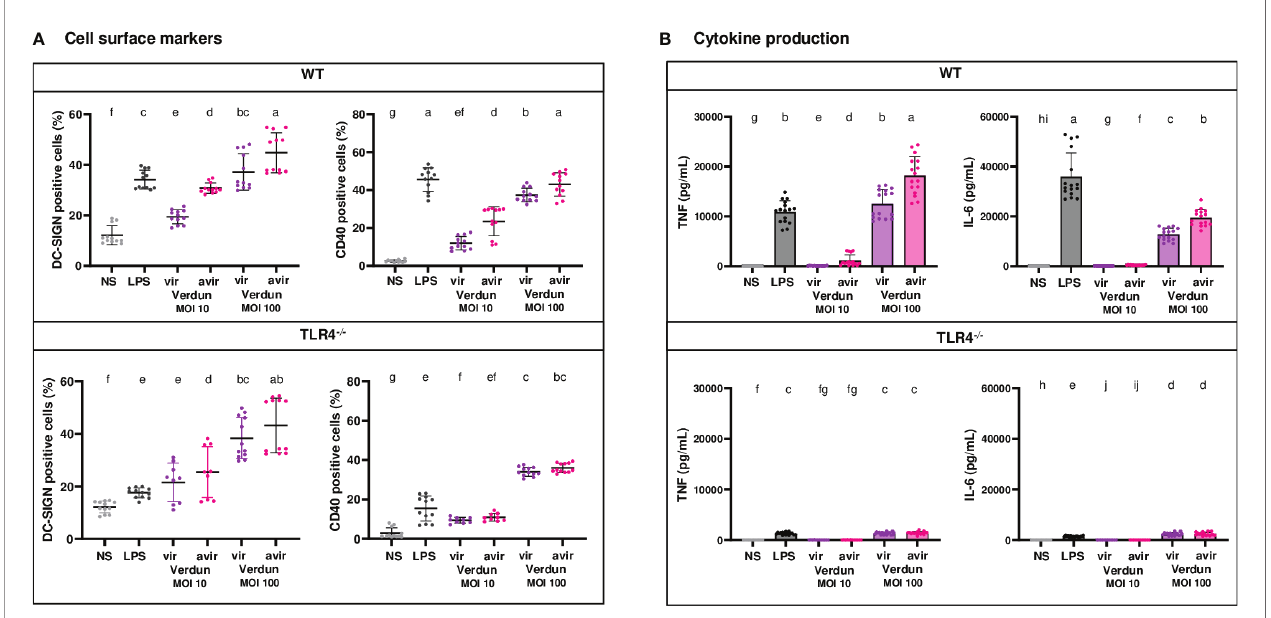
FIGURE 5 | Contribution of TLR4 in the difference of BM-DCs activation upon stimulation with virulent compared to avirulent Verdun strains of leptospires. Day 8 WT and TLR4 -/- BM-DCs from C57BL/6 mice were stimulated with virulent and avirulent leptospires from the Icterohaemorrhagiae Verdun (Verdun vir and Verdun avir) strains at a Multiplicity of Infection (MOI) of 10 or 100 bacteria per cell. E . coli LPS (1 µg/mL) was used as a positive control for DCs stimulation. After 24h, cells were immunostained for the analysis of the expression of DC-SIGN and CD40 by fl ow cytometry (A, dot plot) and TNF and IL-6 concentrations were also quanti fi ed in cell supernatants by ELISA assays (B, histograms with dot plot). Data were compared to results with non-stimulated cells (NS). Each dot represents technical triplicates (A) or quadruplicates (B) from two independent experiments with n=4 mice. Mean ± SD is also represented. Statistics indicated with lower-case letters allow for comparing, for each marker and each cytokine, all conditions within WT (upper panel) and TLR4 -/- (lower panel). Conditions that share the same lower-case letters are not signi fi cantly different (p > 0.05). In contrast, conditions that do not share same letter(s) are signi fi cantly